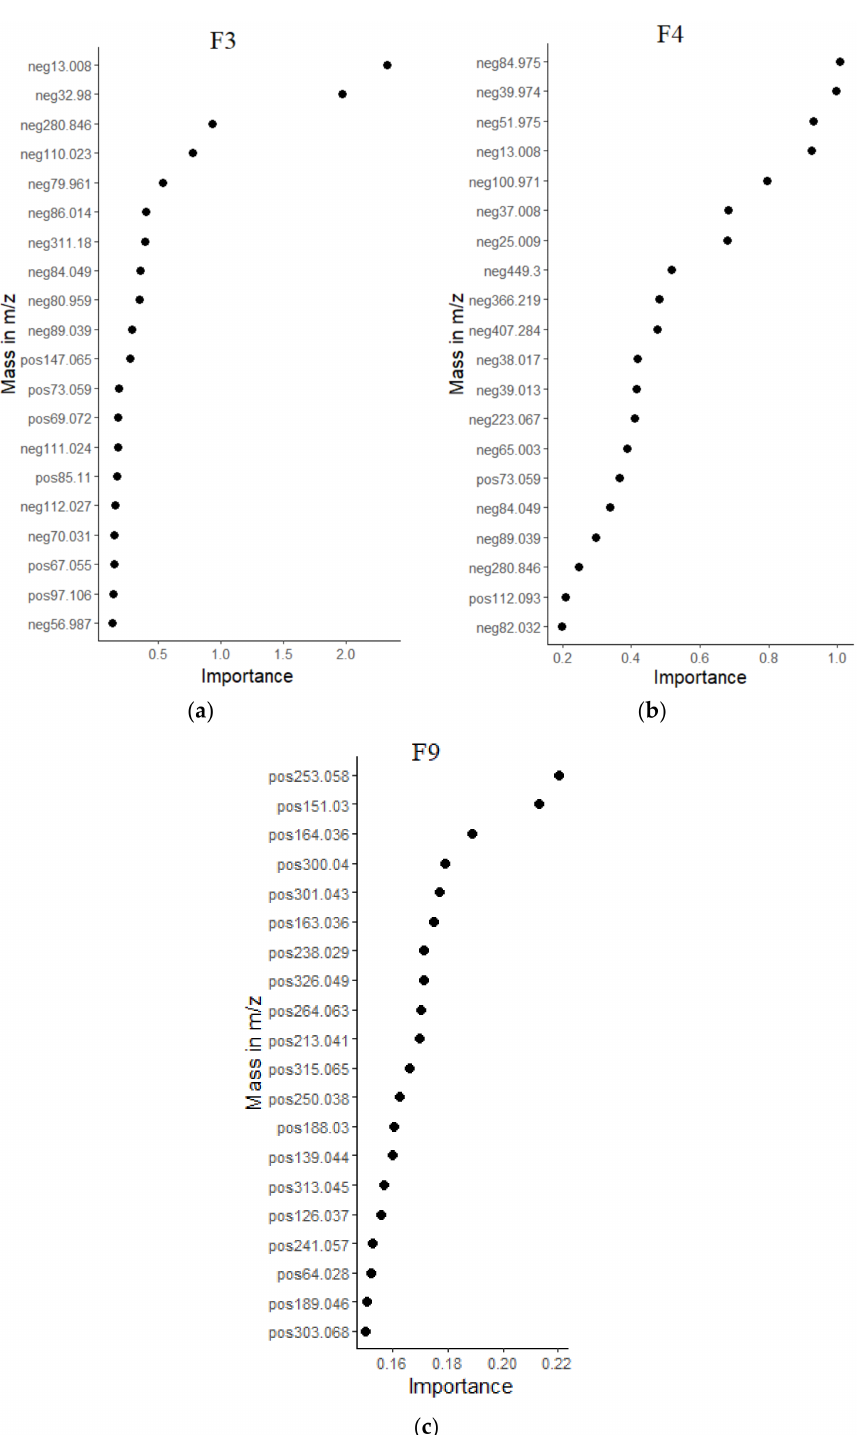
Figure 4. The pattern of impurity-based important masses depicting sorption of fulvic acids onto n-TiO 2 ⊂ sunscreen evaluated by using RF. ( a ) n-TiO 2 ⊂ sunscreen (3) exposed to fulvic acids; ( b ) n-TiO 2 ⊂ sunscreen (4) exposed to fulvic acids; ( c ) n-TiO 2 ⊂ sunscreen (9) exposed to fulvic acids (“neg” and “pos” indicates negatively and positively charged secondary